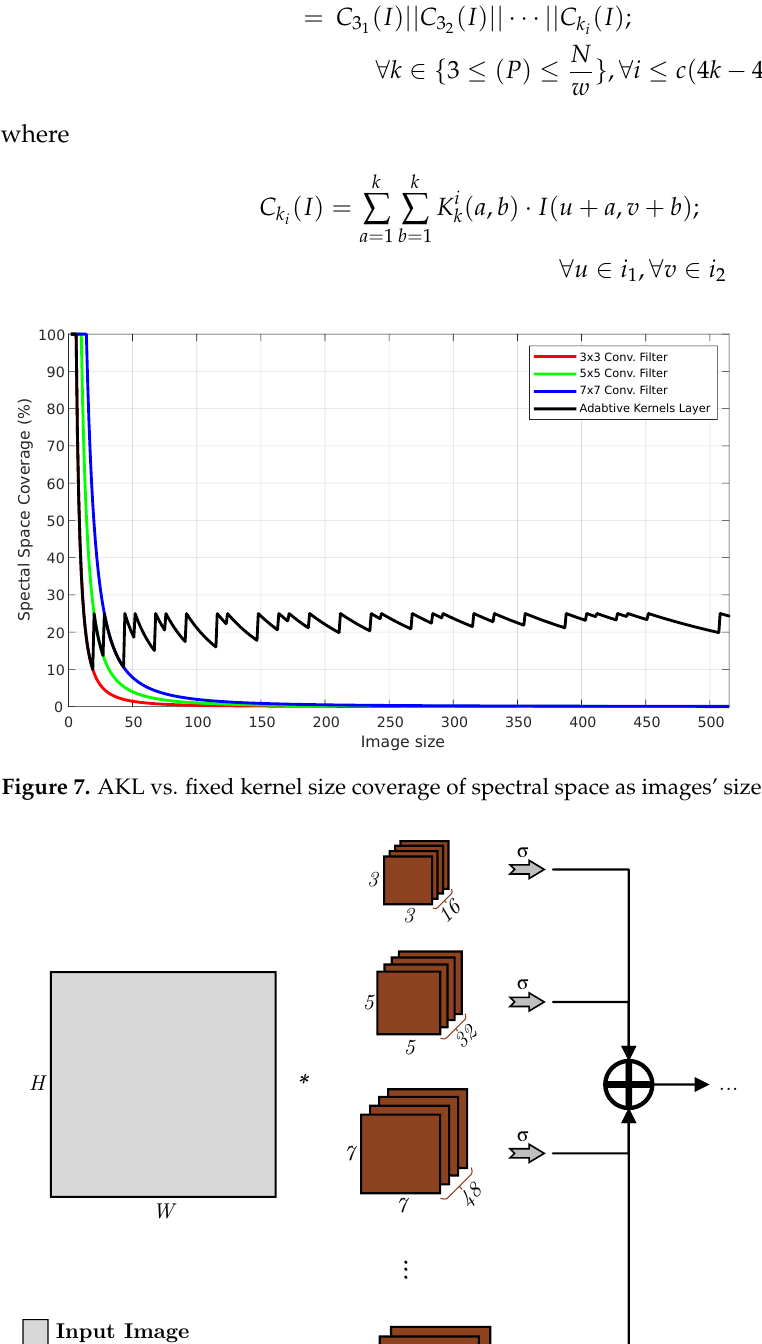
2. “ 2. Figure 8. An overview of the adaptive kernels layer using c = “